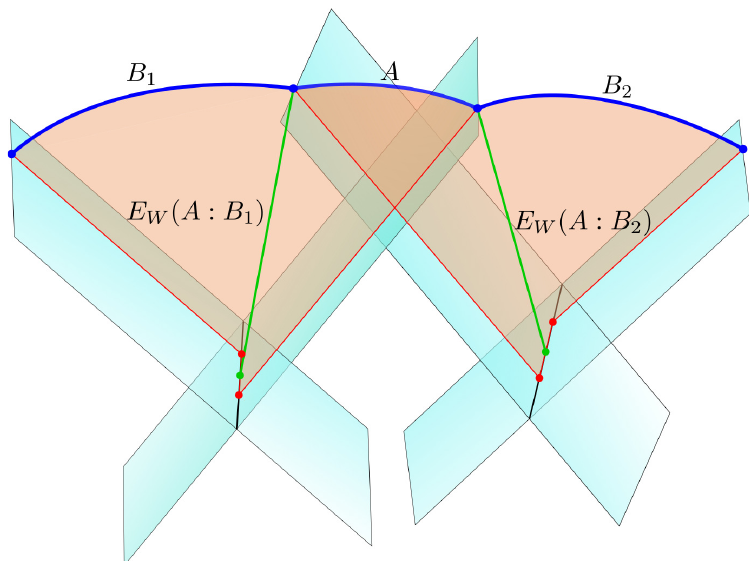
Figure 6: EWCS construction for a single interval in a thermal GCF T the FSC geometry. Note that the EWCS shown by the green curves only provide a schematic while the actual construction for adjacent intervals requires a regulariza- tion prescription as discussed in section